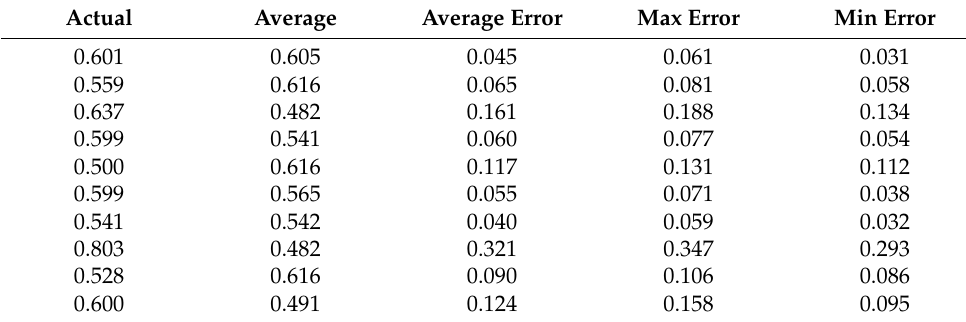
Table A113. Set 2, trials 21–30 data (average actual PR values).